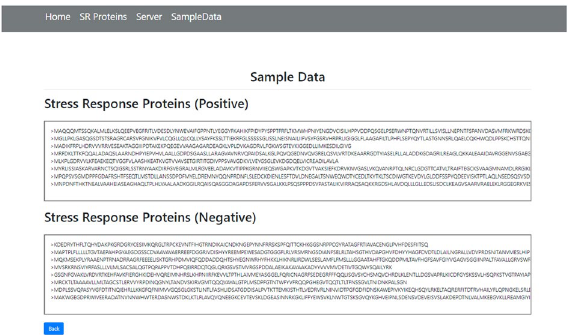
Figure 17. Sample data page.